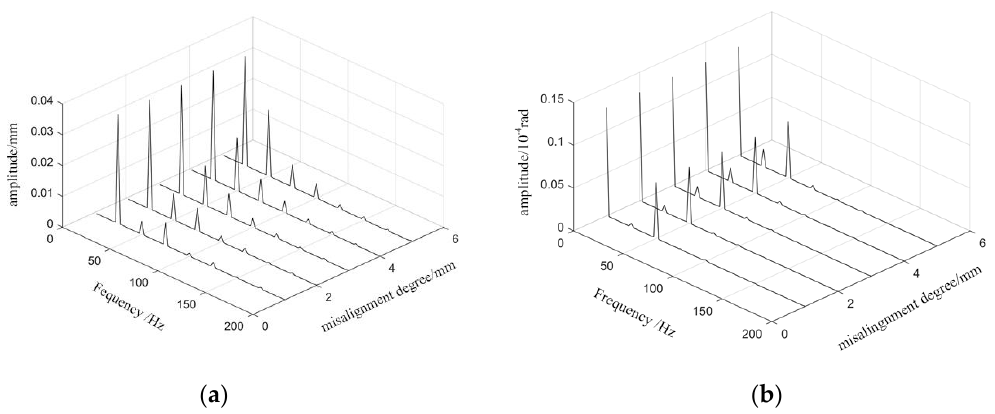
Figure 20. Coupled fault system vibration response with Stator short-circuit 10%: ( a ) Radial vibration spectrum waterfall diagram; ( b ) Torsional vibration spectrum waterfall diagram.